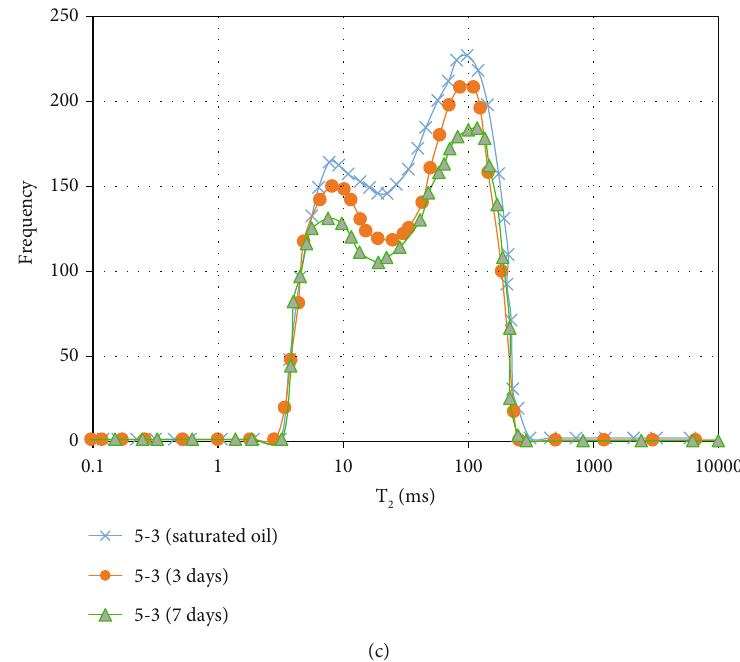
Figure 5: NMR scanning results for 5-1 (a), 5-2 (b), and 5-3 (c).